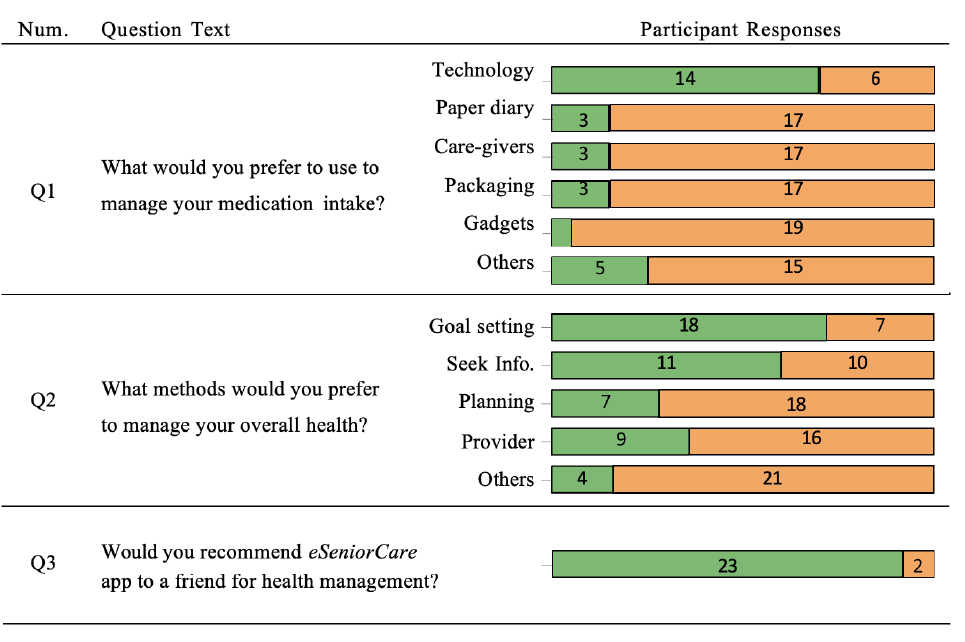
Figure 5. Questions and response trends for the Short Survey (Notes. Green color segment denotes ‘Yes’ while Orange denotes ‘No’ to the indicated option. The number values in the colored bar segments denote the number of participants who gave the corresponding response, while the length of the colored segment denotes the proportion of participants who agreed with the corresponding